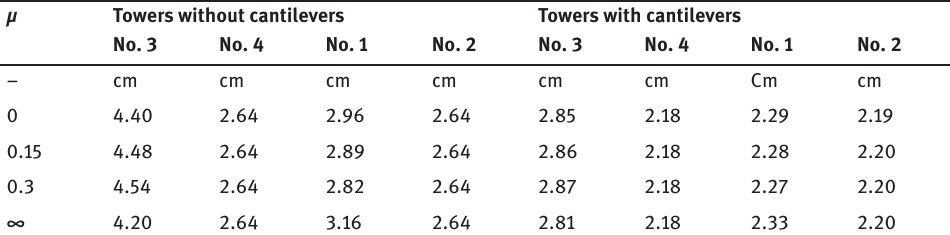
Table 3: Radial displacements of the shell in a connection point for the wind W2. µ Towers without cantilevers Towers with cantilevers